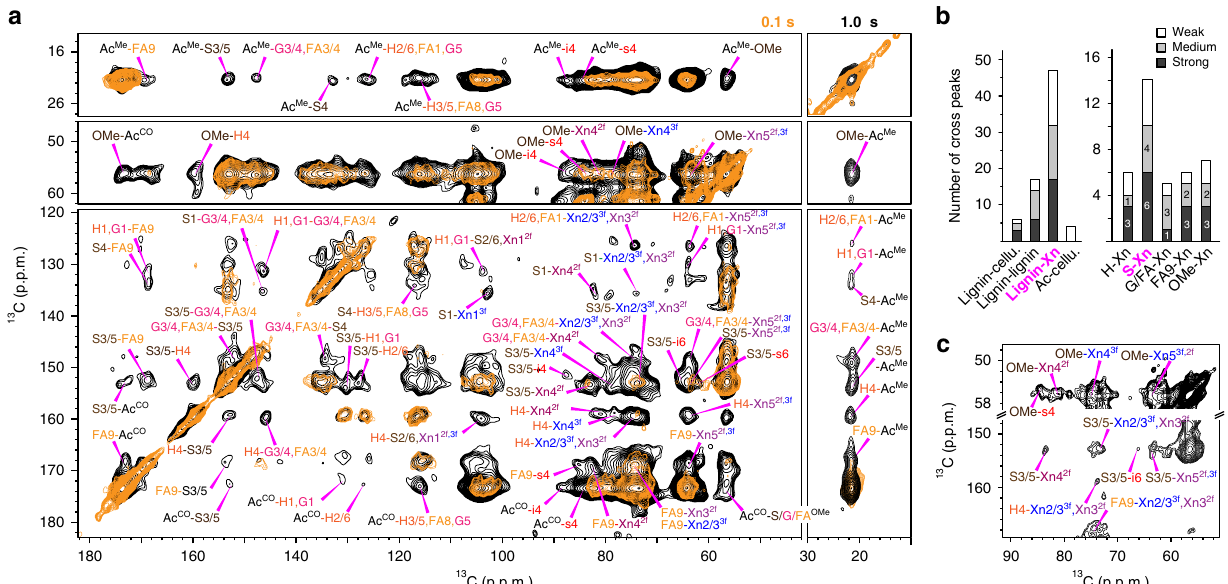
Fig. 2 Electrostatic interactions of xylan and S units dominate lignin-polysaccharide interactions in maize. a Representative 13 C – 13 C spectra measured with short (0.1 s, orange) and long (1 s, black) mixing times on maize. The 1-s spectrum shows many long-range intermolecular cross peaks that are absent in the 0.1-s spectrum. Only intermolecular cross peaks are labeled. b Summary of the 74 intermolecular cross peaks in maize. For each category, the peaks are grouped by their strength. Cellulose is abbreviated as cellu. The interaction types with the most cross peaks are highlighted in magenta. Lignin-xylan contacts dominate, with the most cross peaks for S. Source Data are provided as a Source Data fi le. c The Xn-S and Xn-OMe cross peaks in the 100-ms spectrum reveal close contacts